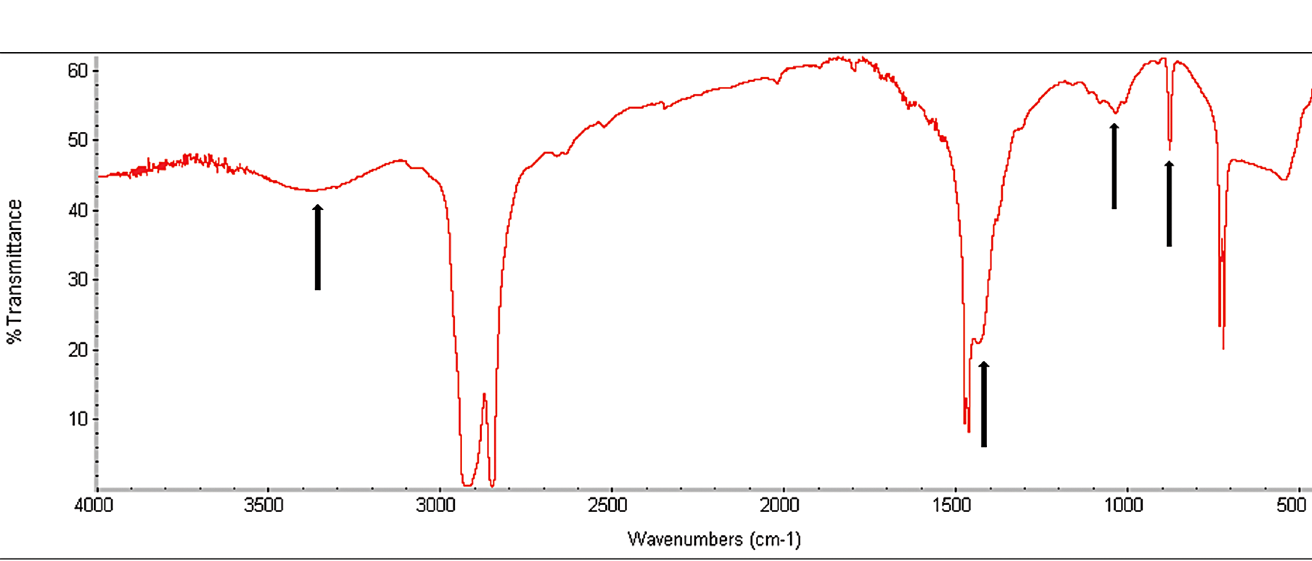
PLOS ONE | DOI:10.1371/journal.pone.0126047 June 15,